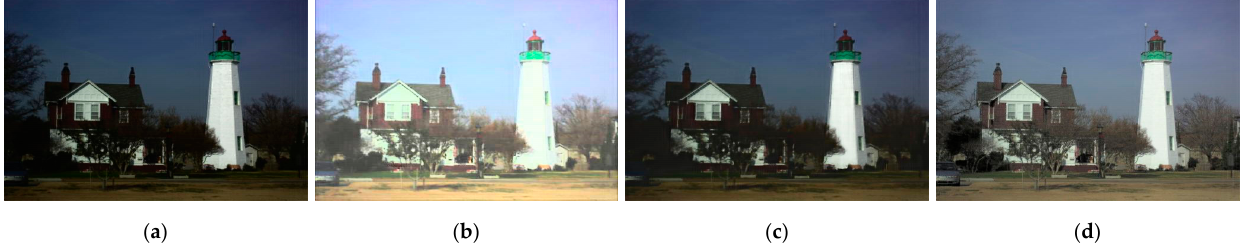
Figure 7. Part of each method’s result: ( a ) input, ( b ) gamma shift augmentation, ( c ) gamma shift with regional weighted loss (RWL) result, and ( d ) gamma shift and RWL with regional fusion training result.